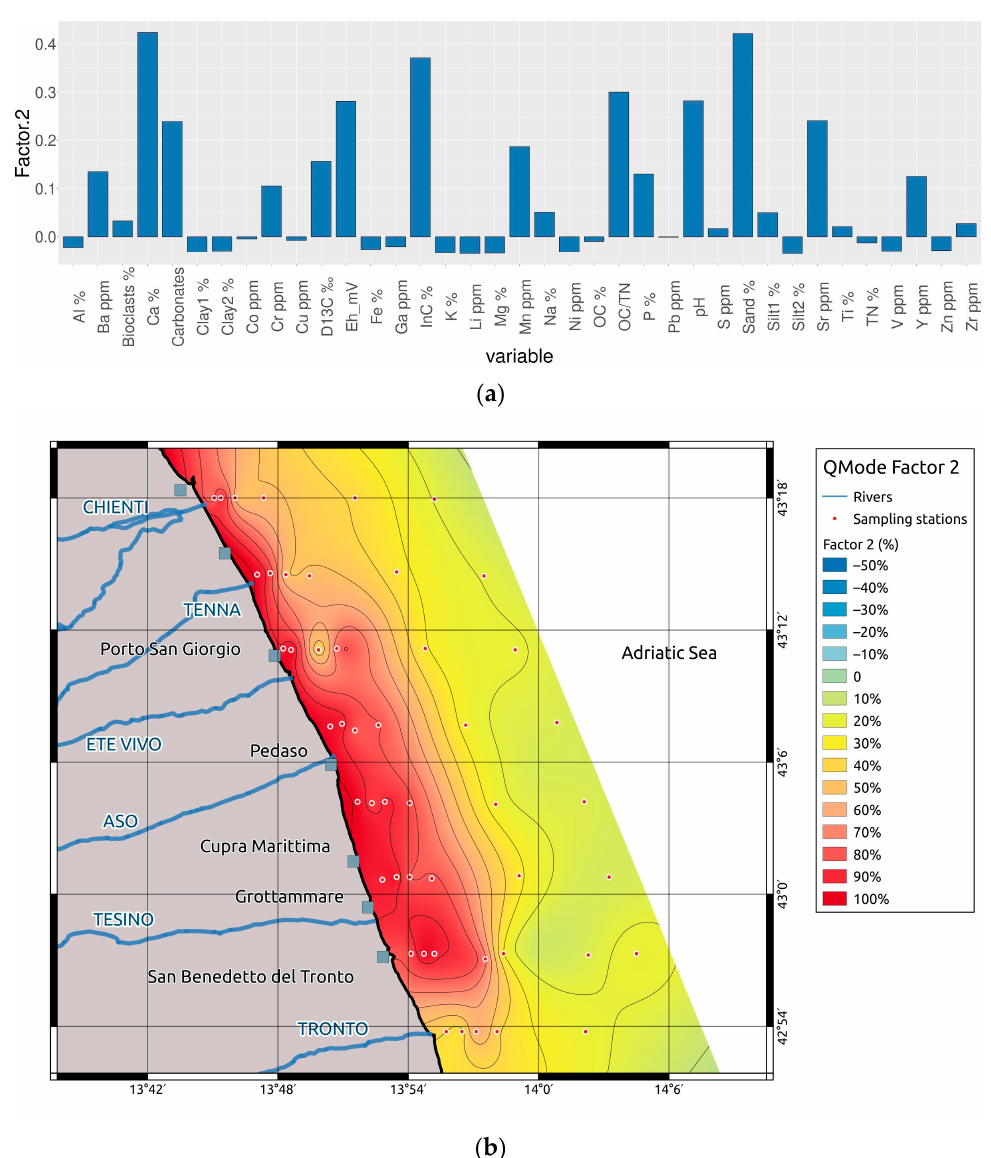
Figure 4. Histogram of the factor scores ( a ) and map of the areal distribution of the of the BSF2 ( b ). The third facie s (BSF3) explains 1.9% of the total variance and is defined by abundant silts, P, Mn, Ba, Sr, and partially Zr (Figure 5a). The highest values of the BSF3 are mostly found along a belt parallel to the coast in an intermediate position between the BSF1 and BSF2 maxima (Figure 5b) with three maximum areas. By considering the distribution of the BSF3 sediments in relation with the hydrography of the central Adriatic Sea, the silty sediments of the BSF3 are the results of the accumulation at depth where the wave action can remove the finer granulometric fractions, but where the coarse sandy coastal material supplied by the local rivers and reworked by the wave motion, is not deposited. Further- more, the presence Zr and P also suggest the presence of heavy minerals like zircon and apatite, while the occurrence of Sr and Mn as well as IC suggest the presence of carbonates. These minerals support the residual nature of these sediments in which heavy minerals and carbonate concentrations increase for the removing of lighter minerals and finer grains. The characteristics of the BSF3 are similar to the Residual Facies of Spagnoli et al. (2014) [4] and can then be partially considered as the same Residual Facies . The two minima near the coast are in front of the Ete Vivo and Tesino rivers: the two rivers that do not